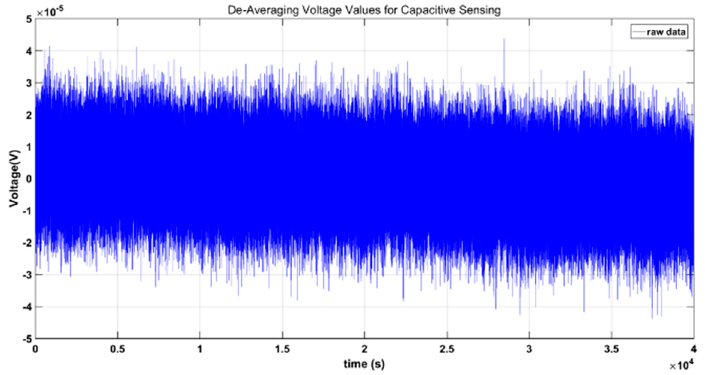
Figure 18. De ‐ averaging the voltage values for capacitive sensing.